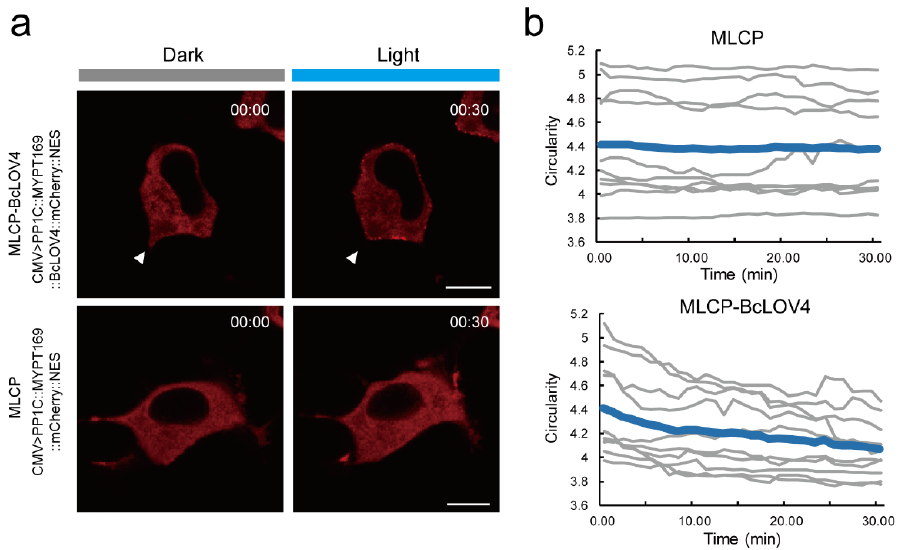
Figure A1. Variation in the circularity of cell sections through the nuclear geometric center. ( a ) Representative images of the expression of the MLCP ‐ BcLOV4 ‐ expressed group (CMV>PP1c::MYPT169::BcLOV4::mCherry::NES, top row) and the MLCP ‐ expressed group (CMV>PP1c::MYPT169::mCherry::NES, bottom row) in HeLa cells. The left is the image in the dark and the right is the image after 30 min of illumination under 488 nm blue light. The white triangle indicates a protrusion, which significantly retracted. Scale bar, 10 μ m; ( b ) The circularity (ratio of the perimeter to the square root of its area) of the cell section through the nuclear geometric center in the MLCP ‐ BcLOV4 ‐ expressed group and MLCP ‐ expressed group changed with time. The thin and bold lines indicate the individual and averaged data, respectively.